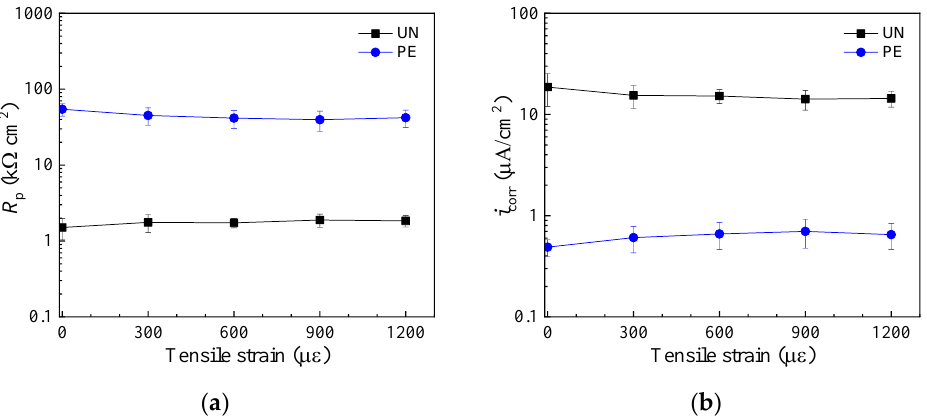
Figure 5. ( a ) Polarization resistance and ( b ) corrosion current density of the uncoated (UN) and enamel (PE)-coated steel rebar in 3.5 wt.% NaCl solution at different strain levels. The corrosion current density of both uncoated and enamel-coated steel rebars at dif-